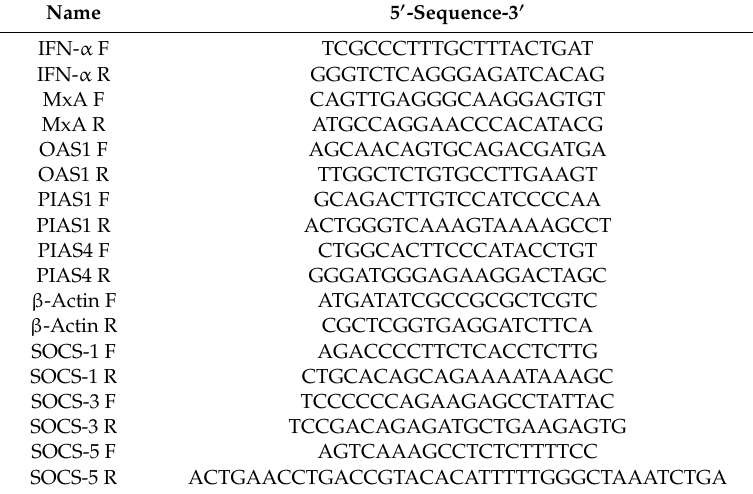
Table 1. List of primers used in